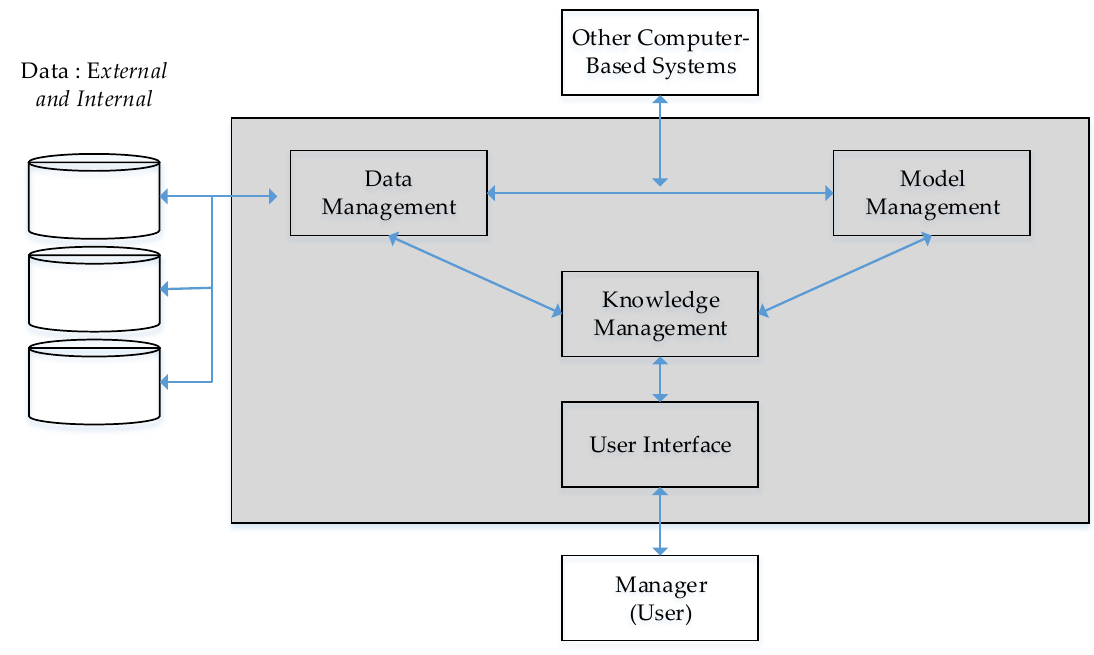
Figure 1. Decision support system components.